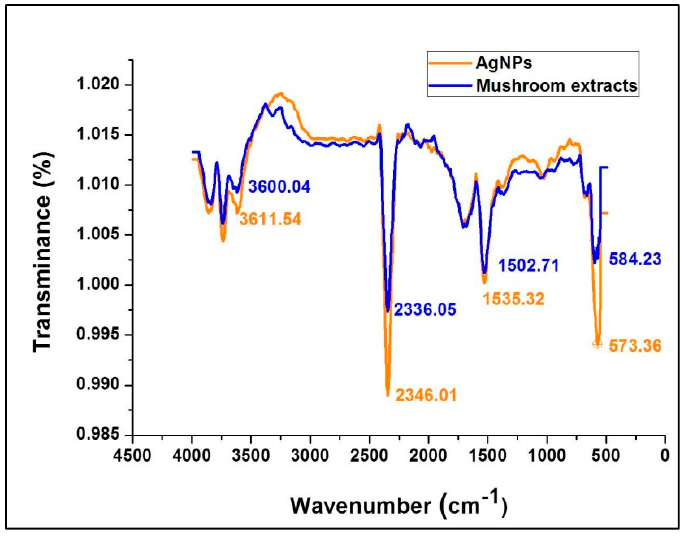
Figure 4. ATR-fourier-transformed infrared spectroscopy analysis of silver nanoparticles (AgNPs) and the aqueous extracts of G. sessiliforme.